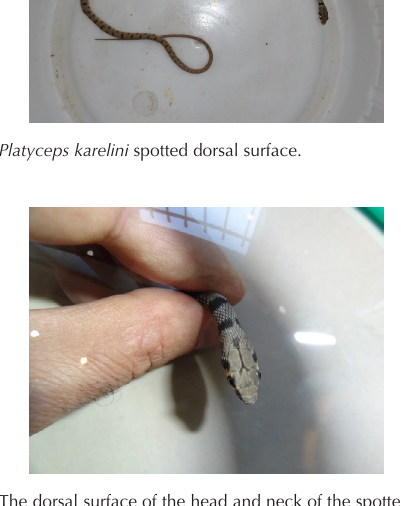
Figure 4. The dorsal surface of the head and neck of the spotted Platyceps karelini.